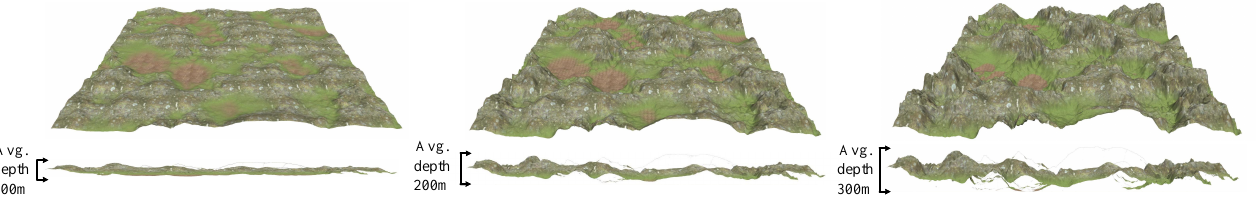
Figure 9. Three synthesized terrains with height differences of 100 m, 200 m, and 300 m,